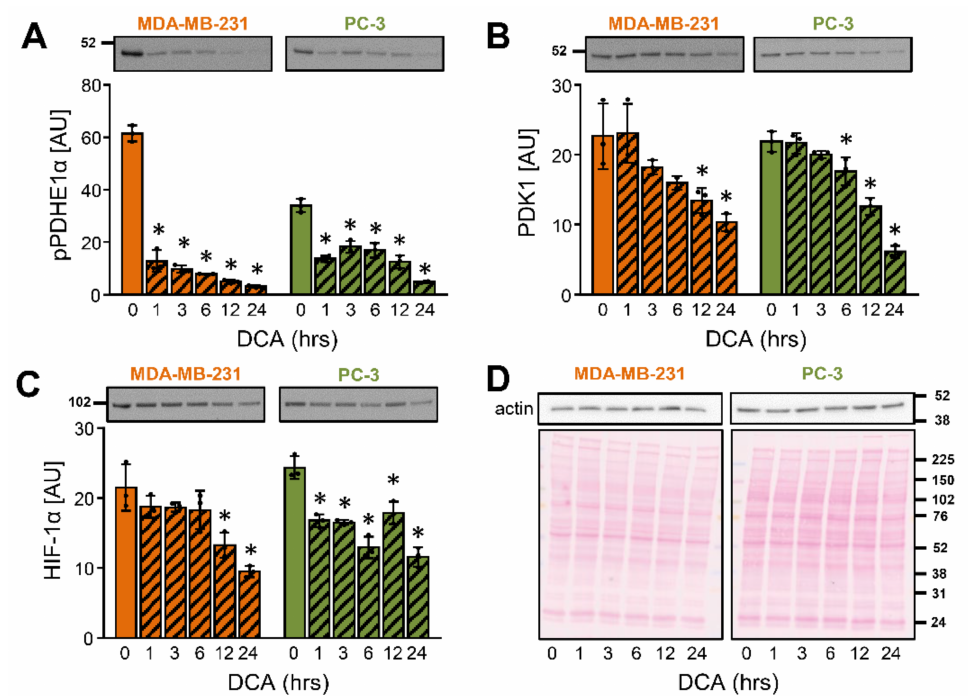
Figure 2. Time-dependent effects of DCA on the PDK1 and HIF-1 α in MDA-MB-231 and PC-3 cancer cells. ( A – D ) Cells were treated with 10 mM DCA in serum-free RPMI medium for 24 h. Protein levels of ( A ) phospho-PDHE1 α Ser293 (pPDHE1 α ), ( B ) PDK1, ( C ) HIF-1 α , and ( D ) β -actin were determined with immunoblotting. ( D ) Ponceau S staining was used for the assessment of protein loading. Numbers next to the blots and Ponceau stains indicate molecular weight markers in kDa. Results are means ± SD of one experiment performed in triplicate for each cell line ( n = 3). * p < 0.05 vs. 0